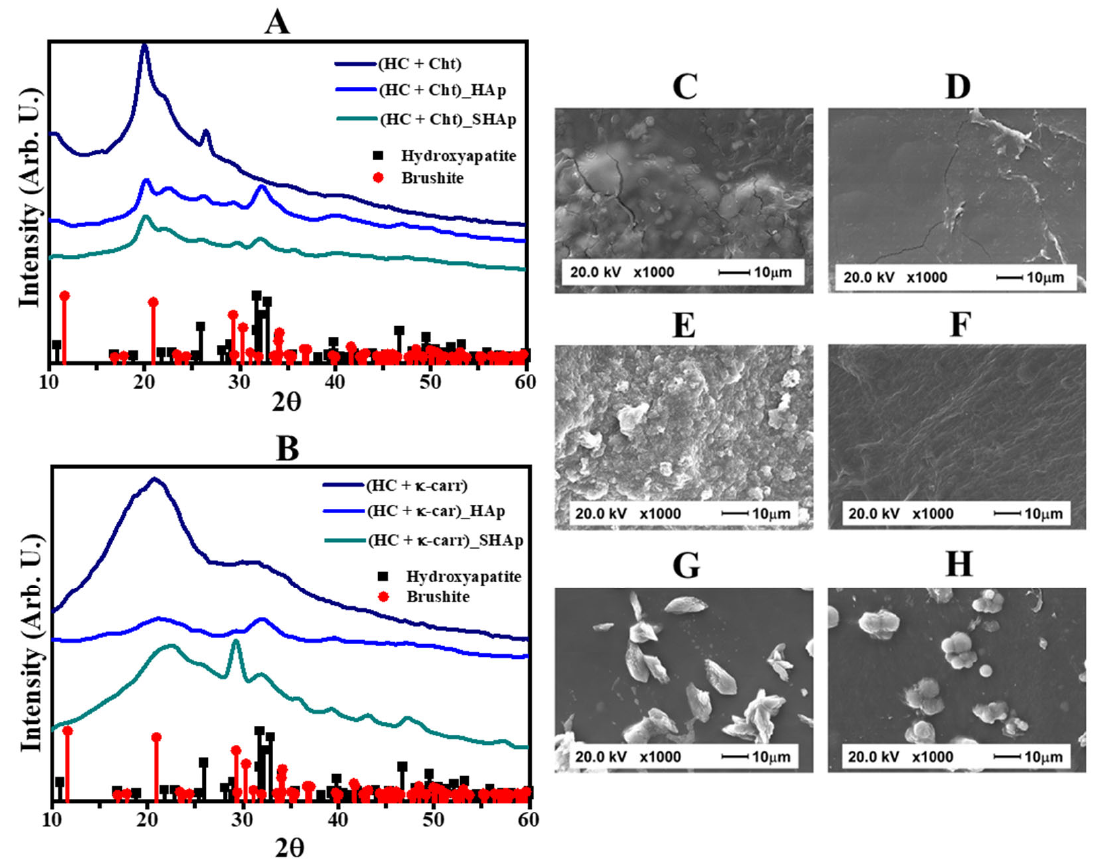
Figure 4. Characterization of the membranes after the bioactivity test carried out by immersion in SBF. X-ray diffraction patterns of the HC-based membranes mixed with ( A ) chitosan (Cht), control—dark blue line, (HC + Cht)_Hap—purple line, (HC + Cht)_SHAp—green line, and ( B ) κ -carrageenan ( κ -carr), control—dark blue line, (HC + κ -carr)_Hap—purple line, (HC + κ -carr)_SHAp—green line. The mineral phases were identified by the diffraction patterns ( ■ ) 9011092 ‐ hexagonal hydroxyapatite and ( ● ) 1533075 ‐ monoclinic brushite from the Crystallography Open Database (COD). SEM images of biopolymeric membranes after exposure to SBF for 30 min ( C ) (HC + Cht) and ( D ) (HC + κ -carr) (controls); ( E ) (HC + Cht)_HAp; ( F ) (HC + κ -carr)_HAp; ( G ) (HC + Cht)_SHAp; and ( H ) (HC + κ